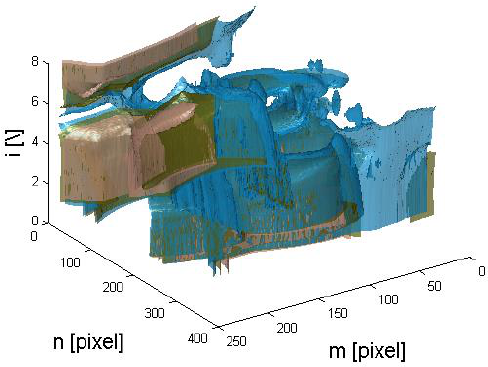
Figure 4. Reconstruction of the three areas most important from the point of view of analysis for T1 = 29, T2 = 32, and T3 = 34 °C.